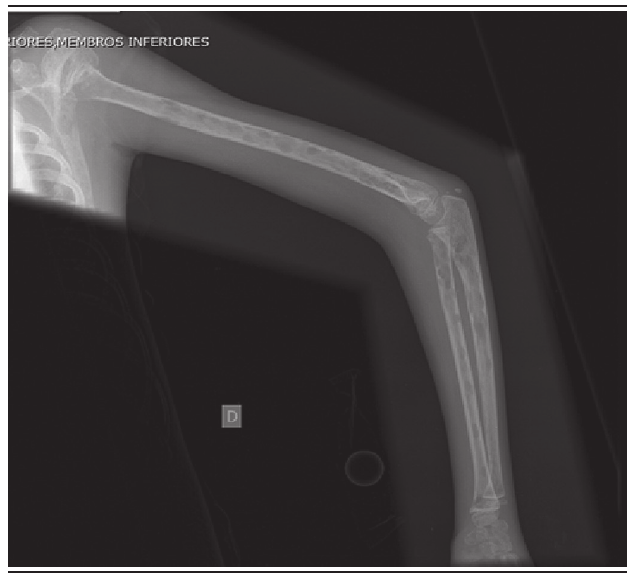
figurE 1 − Radiological aspects of right upper limb: multiple lytic bone lesions Radiological image shows multiple lytic bone lesions in the right upper limb.